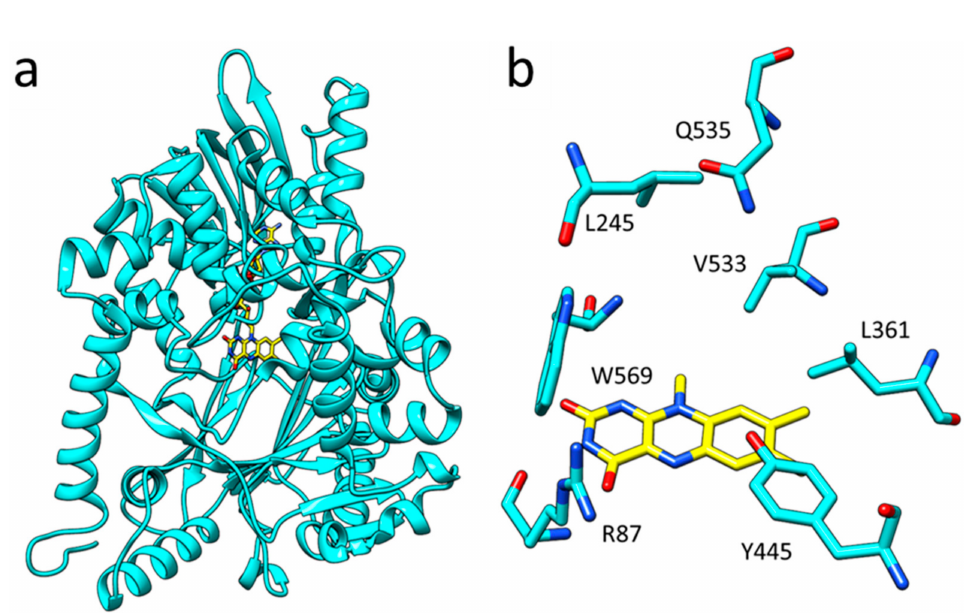
Figure 2. ( a ) The overall structure of Pl -LAAO monomer in cyan ribbons and the FAD cofactor highlighted in yellow sticks. ( b ) Close-up of the active site, with the isoalloxazine moiety of the flavin cofactor in yellow and active site residues in